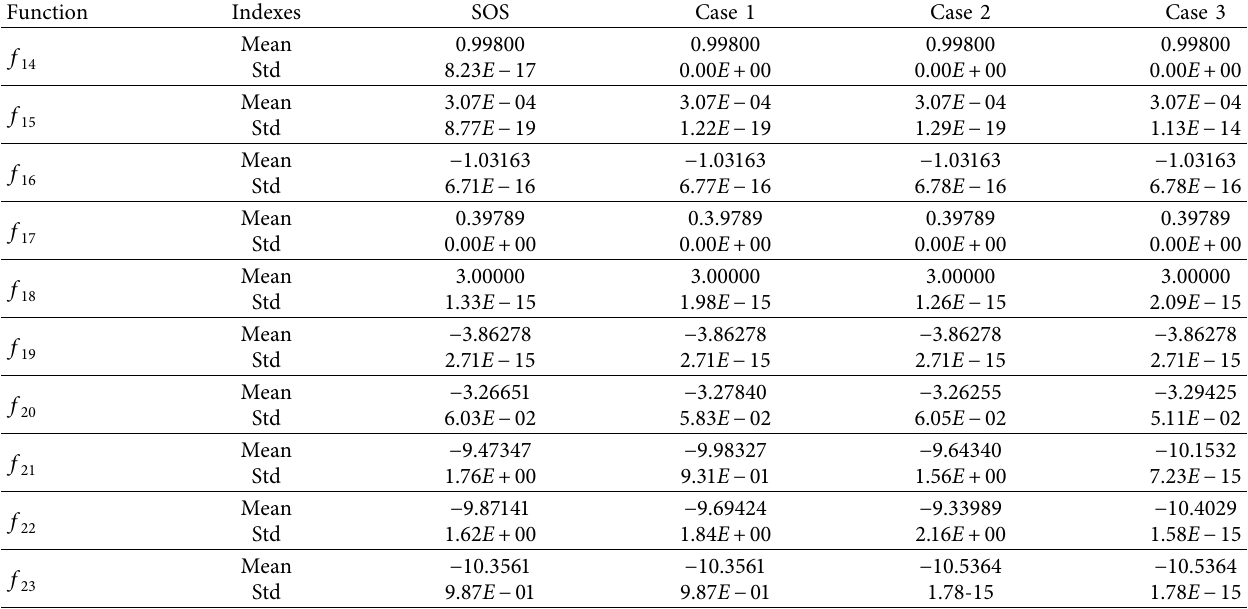
Table 8: Efect of the three cases on the SOS for fxed-dimension multimodal